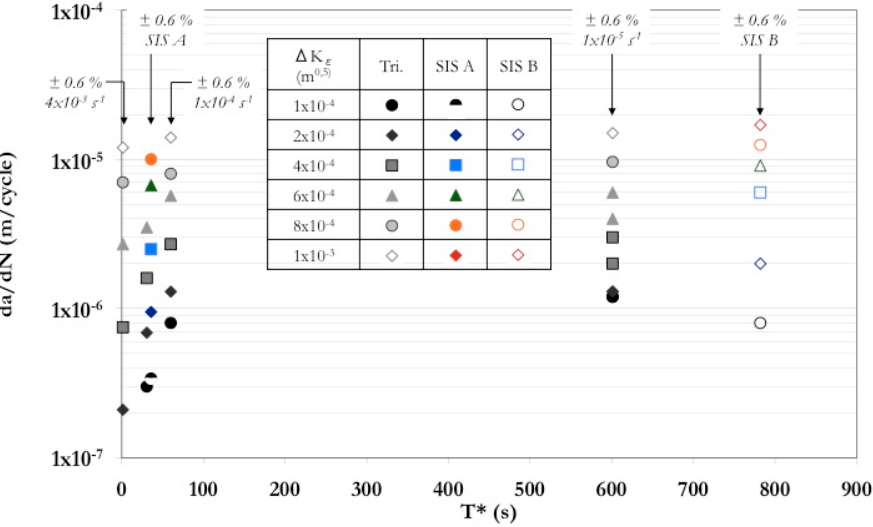
Figure 16. Fatigue crack growth rates plotted as a function of the T * parameter for selected ∆ K ε values.